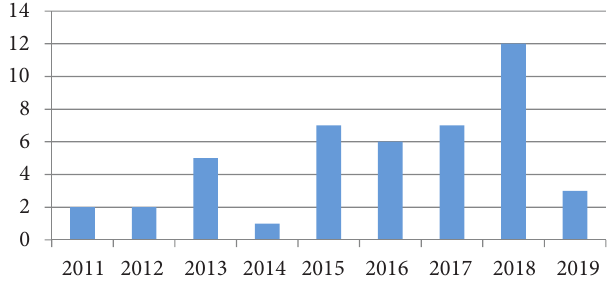
Figure 1. Number of articles per year (source: authors,